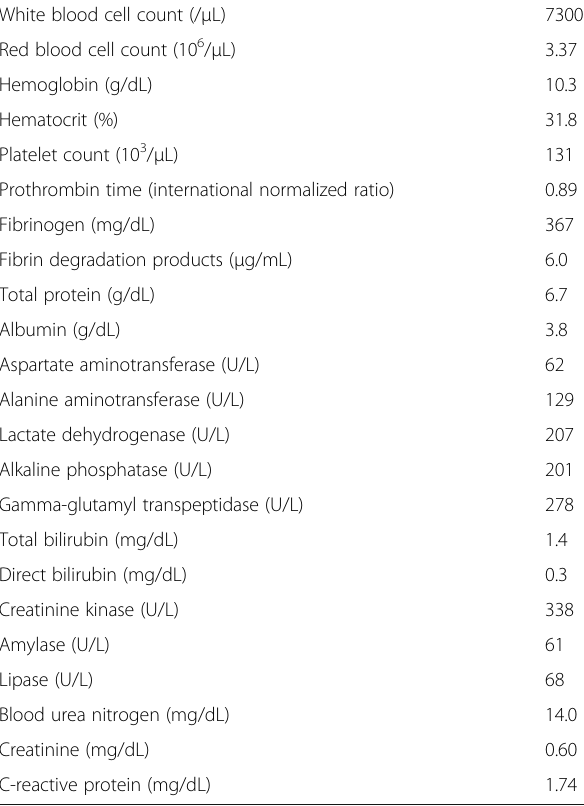
Table 1 Laboratory findings on